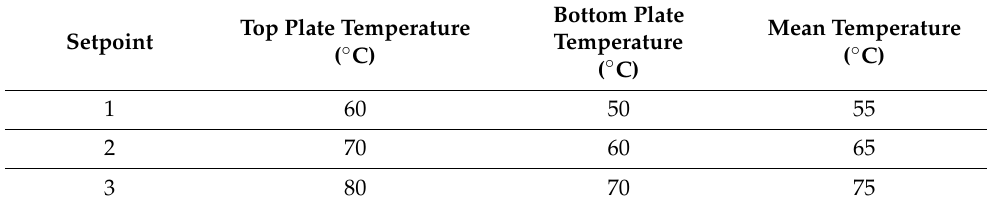
Table 2. The temperature range for thermal conductivity